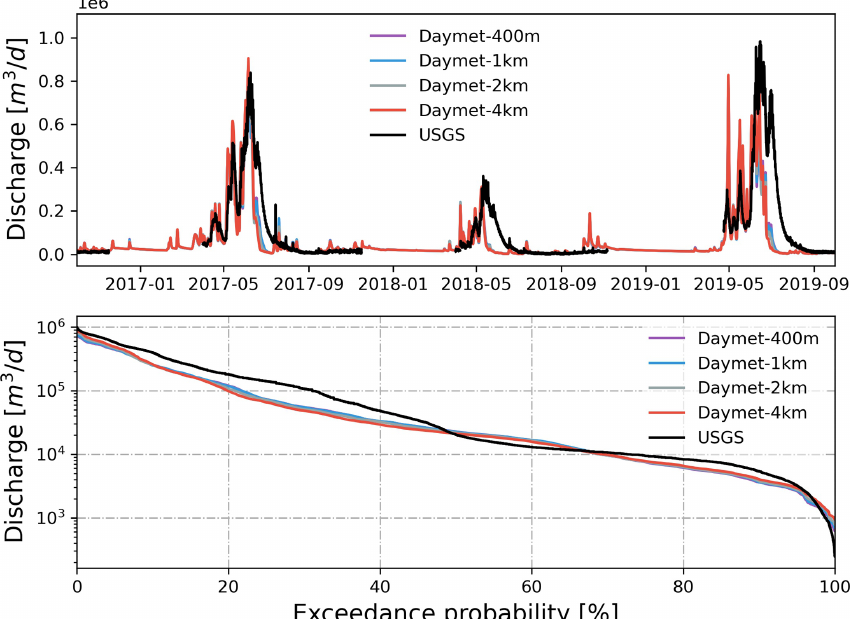
Figure A3. Simulated discharge at the watershed outlet compared to the USGS gage under different spatial resolutions of Daymet. Also shown is the flow duration curve